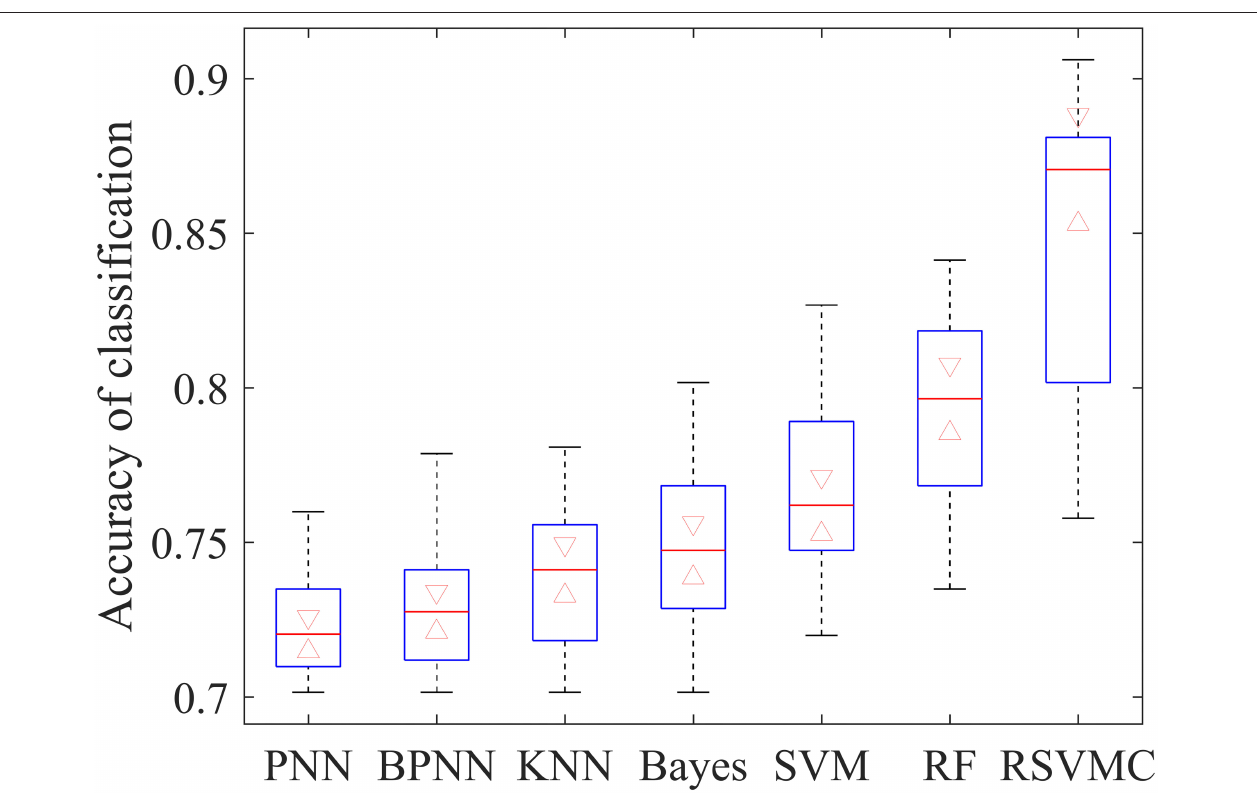
FIGURE 2 | Classification accuracy of different classification